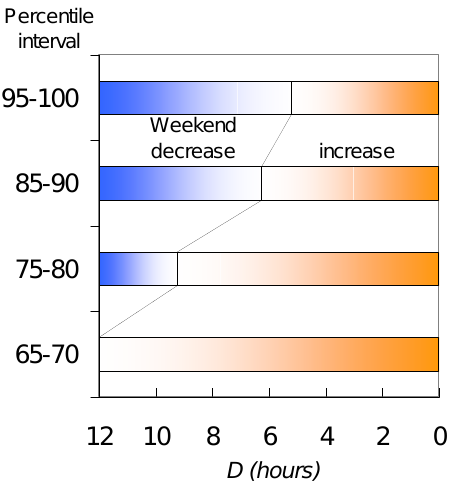
Fig. 11. Changes in the OWE reversal point with normalized dis- tance D , simulated for various percentile rank intervals meteoro- logical conditions in the TMA. Initial concentrations of VOC and NO x on weekdays and Sundays are those indicated by A and B, respectively, in Fig. 8 (VOC 0 /NO x0 = 8 and 11.3,